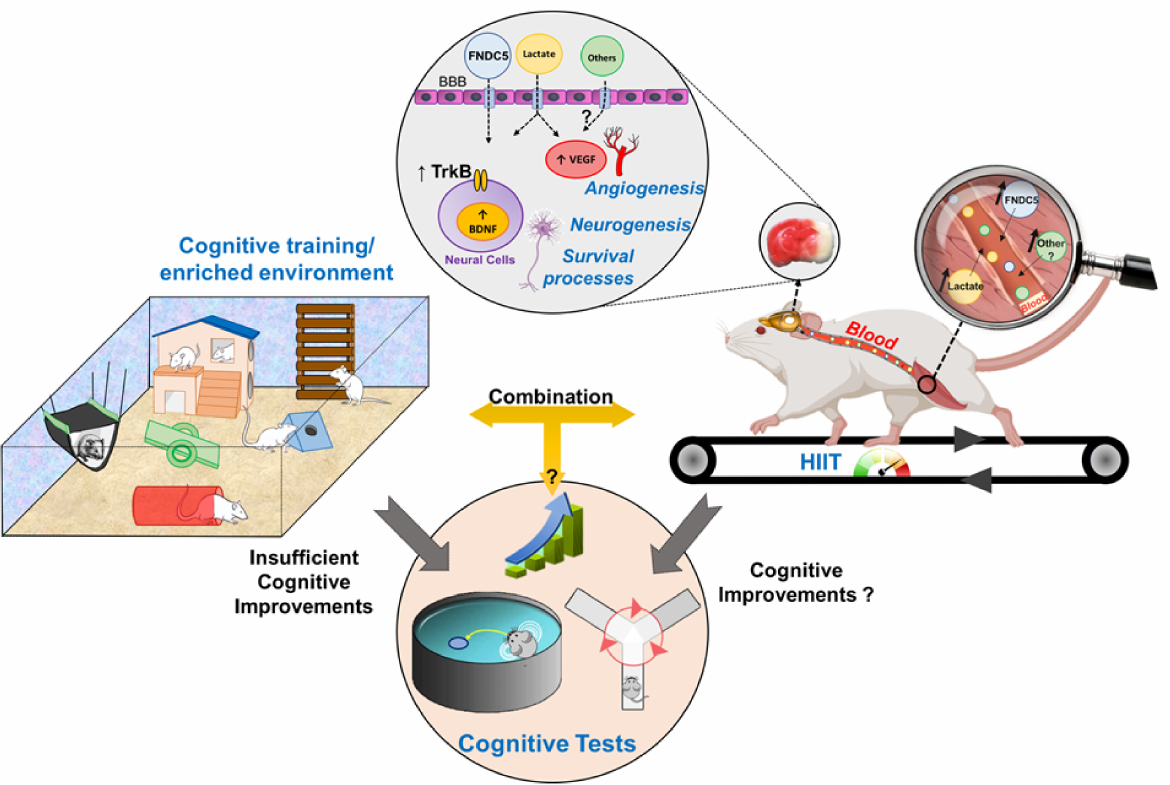
Figure 2. Overview of the influence of high-intensity interval training (HIIT) and cognitive training on neuroplasticity and learning/memory performance in rodents with cerebral ischemia. HIIT enhances neurotrophin expression, neurogenesis and synaptic plasticity. However, the effects on cognition remain unclear but seem to be very modest. It is unknown if the combination between HIIT and cognitive training (enriched environment) can increase benefits of an enriched environment on cognitive functions. Grey arrows mean effects of each type of training on cognitive functions (in the beige circle at the bottom). “?” means that it remains unknown (no